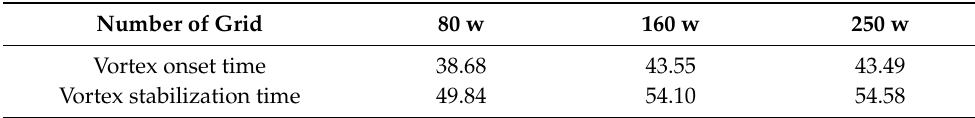
Table 2. Grid dependency study based on the